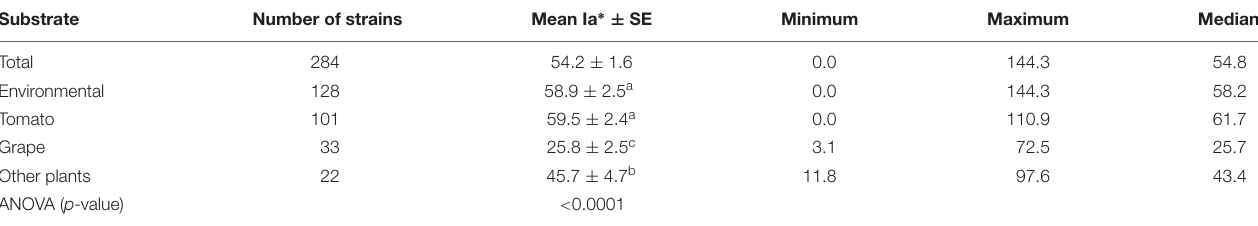
FIGURE 2 | Aggressiveness of 128 environmental strains (A) and 156 agricultural strains (B) of B. cinerea on tomato plant in controlled condition (21 ◦ C, RH > 80%, photoperiod 14 h, 114 µ mol m − 2 s − 1 ). Index of aggressiveness (in %) was calculated for each strain, relative to the reference strain BC1 (hatched). The horizontal red bar corresponds to an index of aggressiveness of 100% (value of BC1). Each value represents the mean of two or three independent repetitions. The vertical bar associated to each histogram correspond to SE. TABLE 4 | Mean and range of aggressiveness of strains of B. cinerea collected on various substrates.